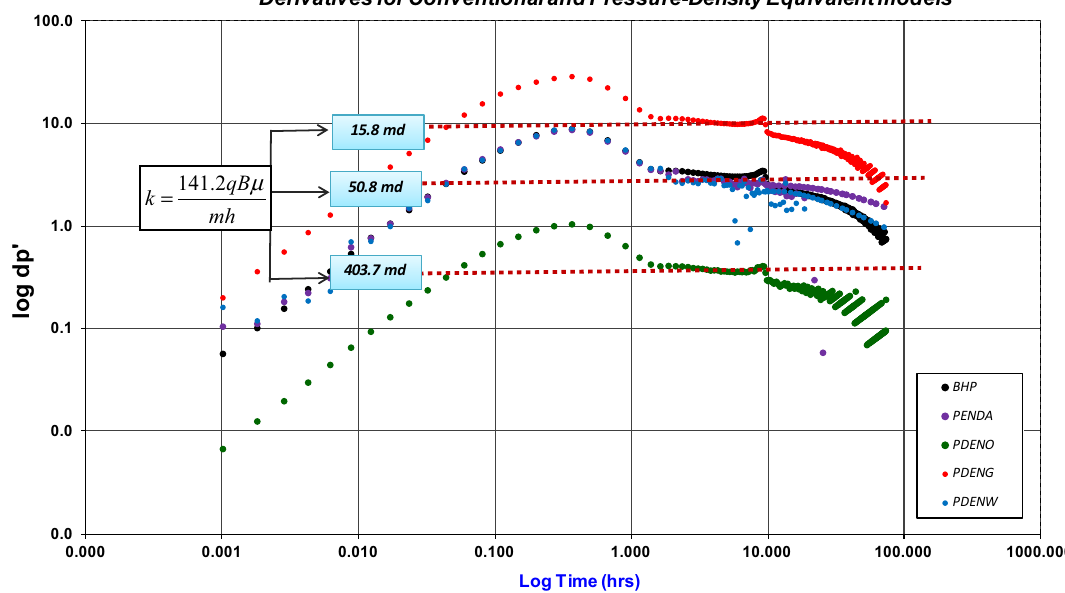
Fig. 11 Conventional BHP and three fluid phases pressure–density equivalent derivatives versus time and k estimates. All three fluid phase (gas, oil and water) with good stabilisation with estimated k for each phase k ¼ 141 : 2 qB l